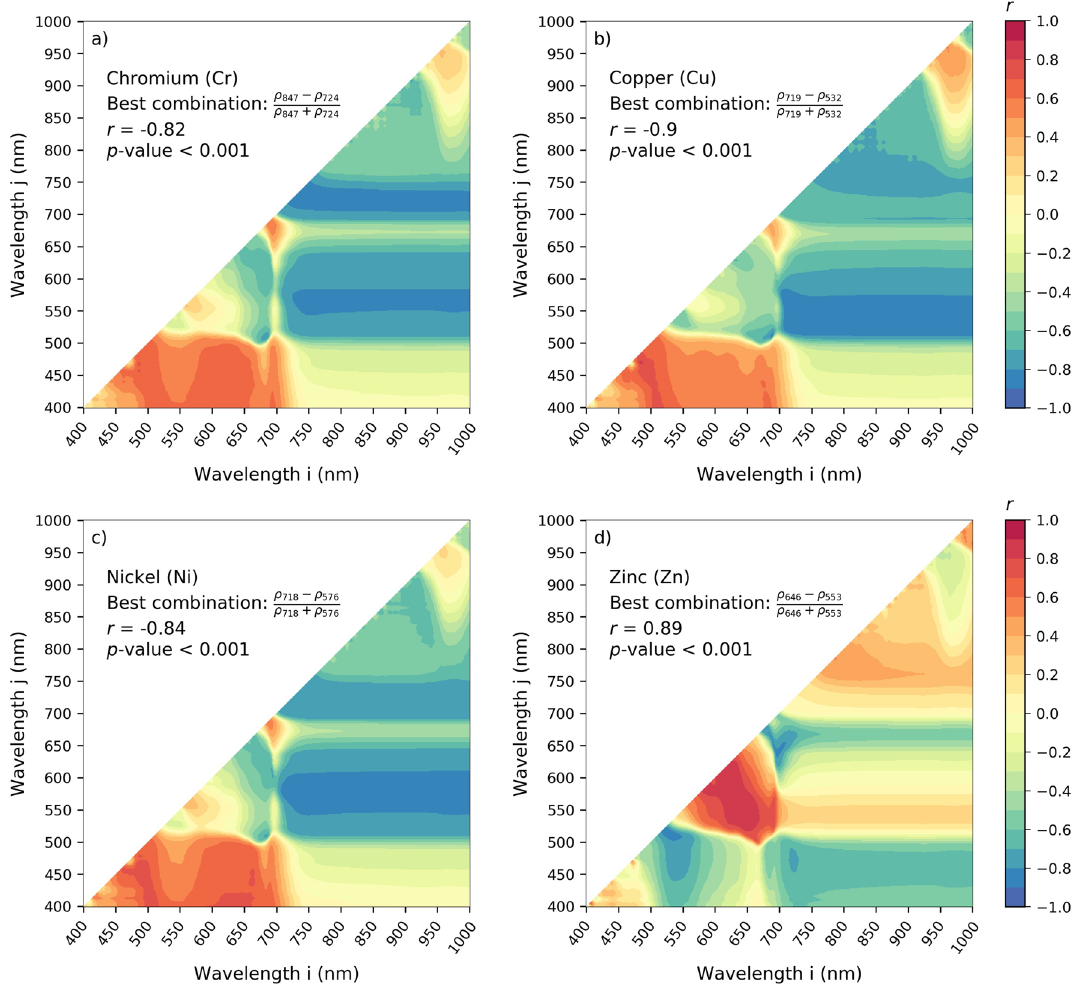
Figure 4. ( a – d ) Correlation maps obtained between all possible combination of wavelengths through the normalized vegetation indices and the four heavy metal contents in leaves ( n = 26). For each combination of wavelength ρ i and ρ j , the normalized index was computed according to Eq. (3), and its correlation with the heavy metal contents was assessed through the Pearson coefficient of correlation ( r ) at the significance level of p < 0.05. The best—optimized—index obtained for the four heavy metals was then retained for prediction purposes. The deep blue and red regions show the highest